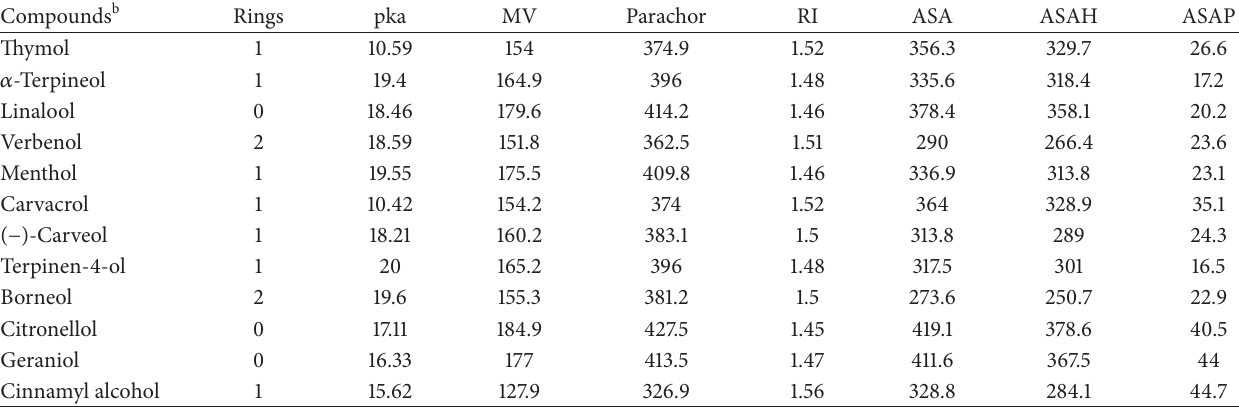
Table 3: Calculated molecular descriptors a for alcohol and phenol compounds used in QSAR analysis of the insecticidal activity against cockroach species.